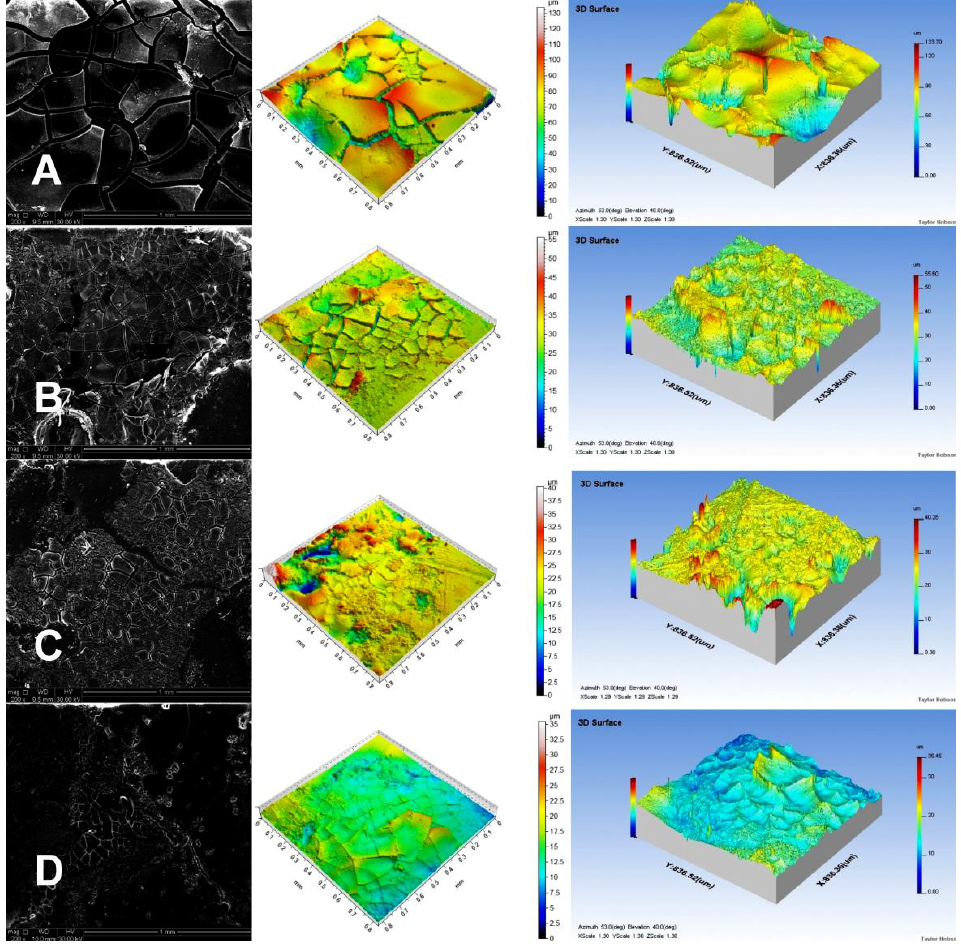
Figure 4. SEM micrographs and profilometer images showing the microstructure of PCL tablets after 28 days in PBS solution at 37 °C and pH 7.4: ( A ) PCL-1-CIT; ( B ) PCL-1-TEMP; ( C ) PCL-2-CIT; ( D ) PCL-2-TEMP.